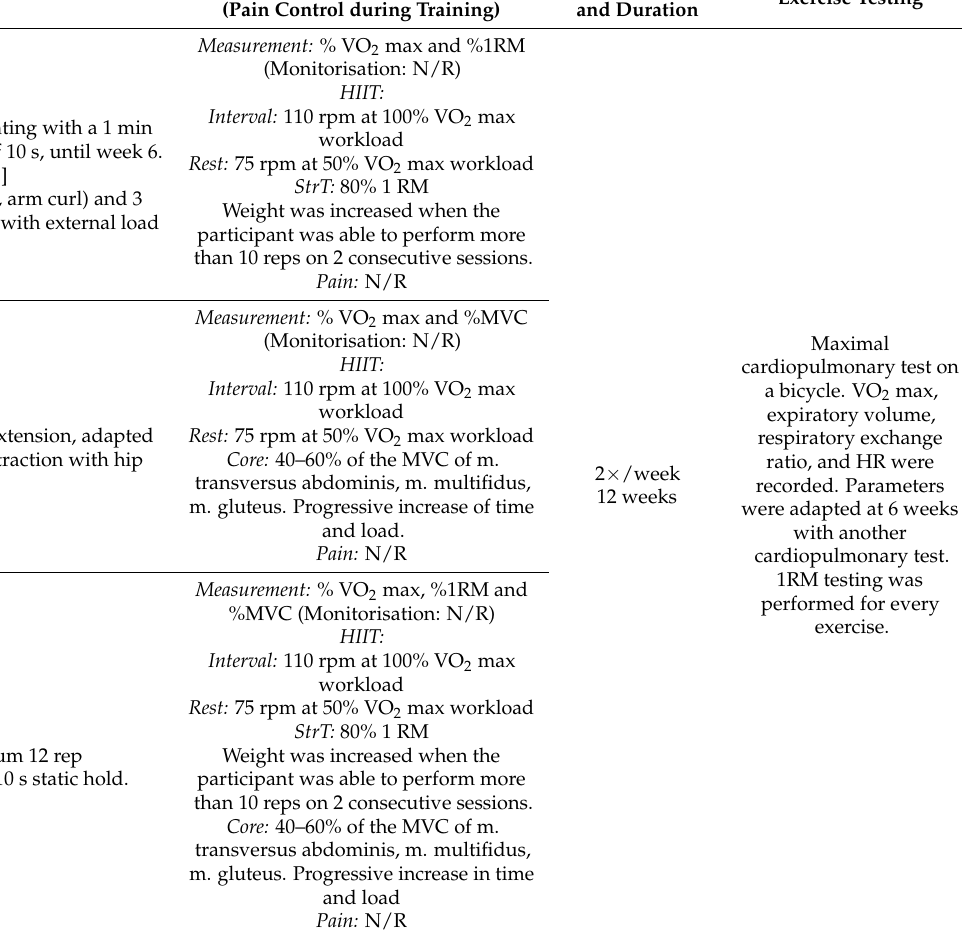
Intensity (Pain Control during Training)